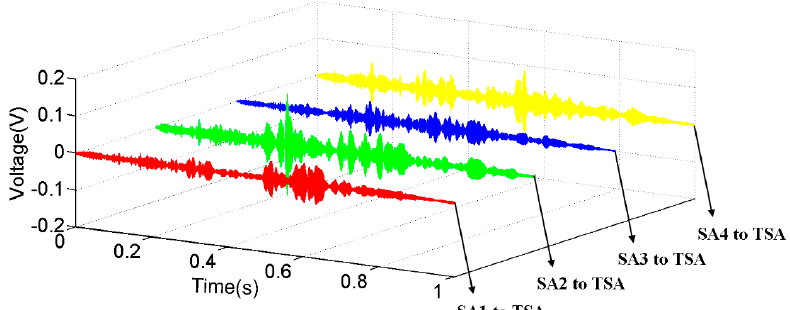
Figure 11. The received signals of the embedded TSA when the surface bonded SAs generated a sweep sine excitation.